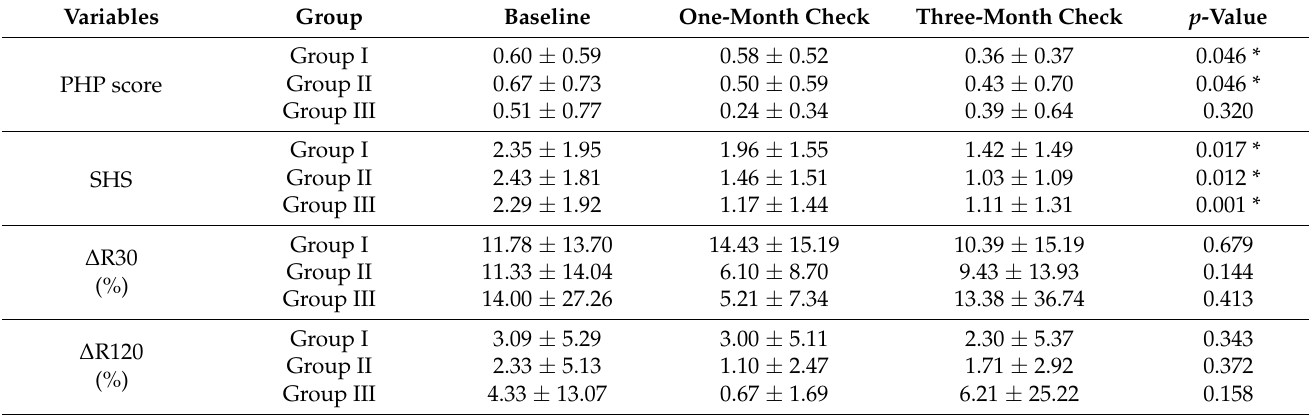
Table 2. Variables of FPI in the three